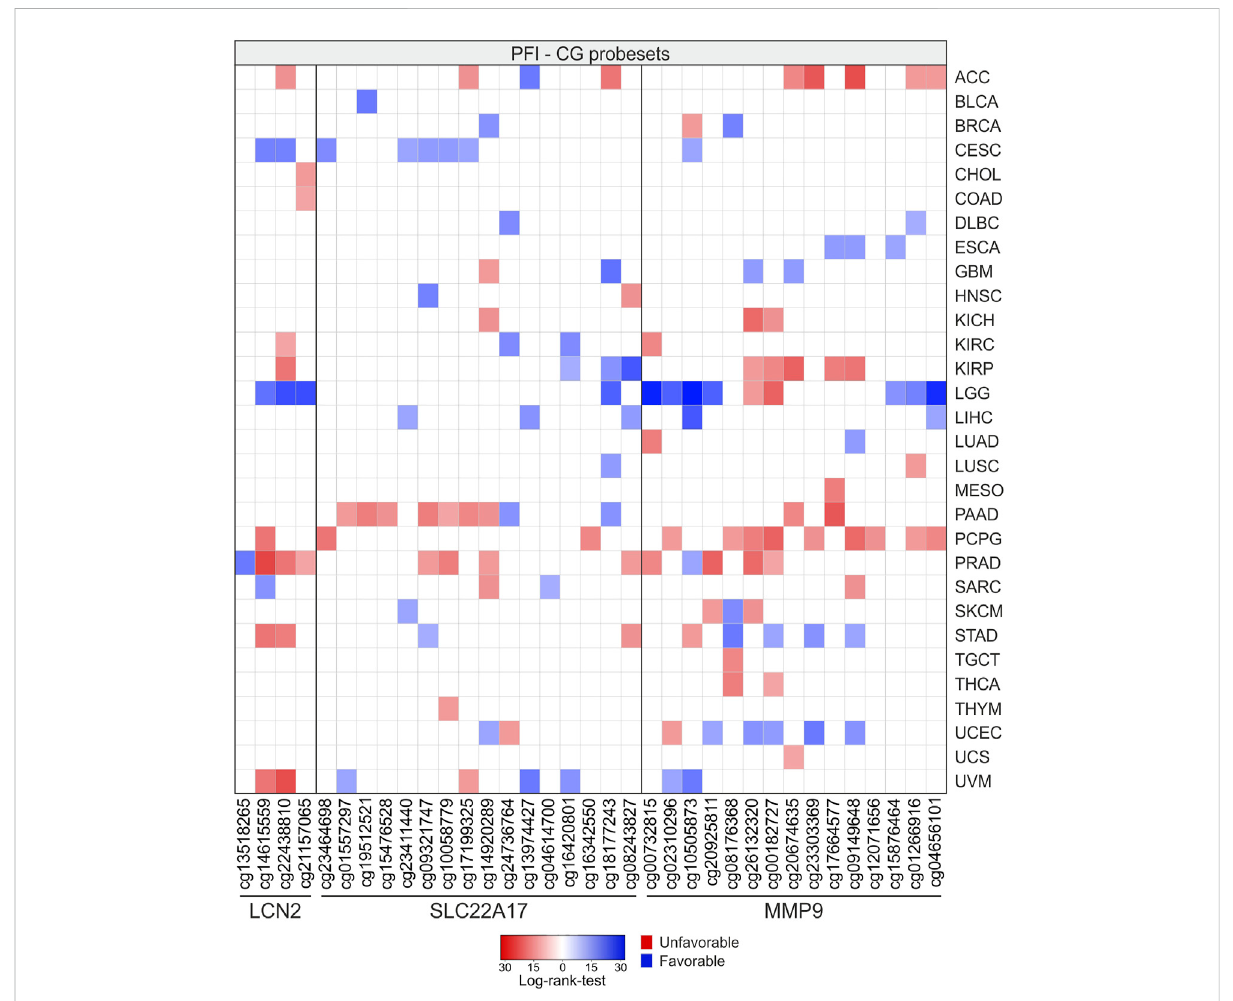
FIGURE 15 PFI analysis according to methylation levels of CG probesets relative to LCN2 , SLC22A17 , and MMP9 in all tumor types. The CG probesets statistically associated ( p ≤ 0.05) with PFI are represented in the